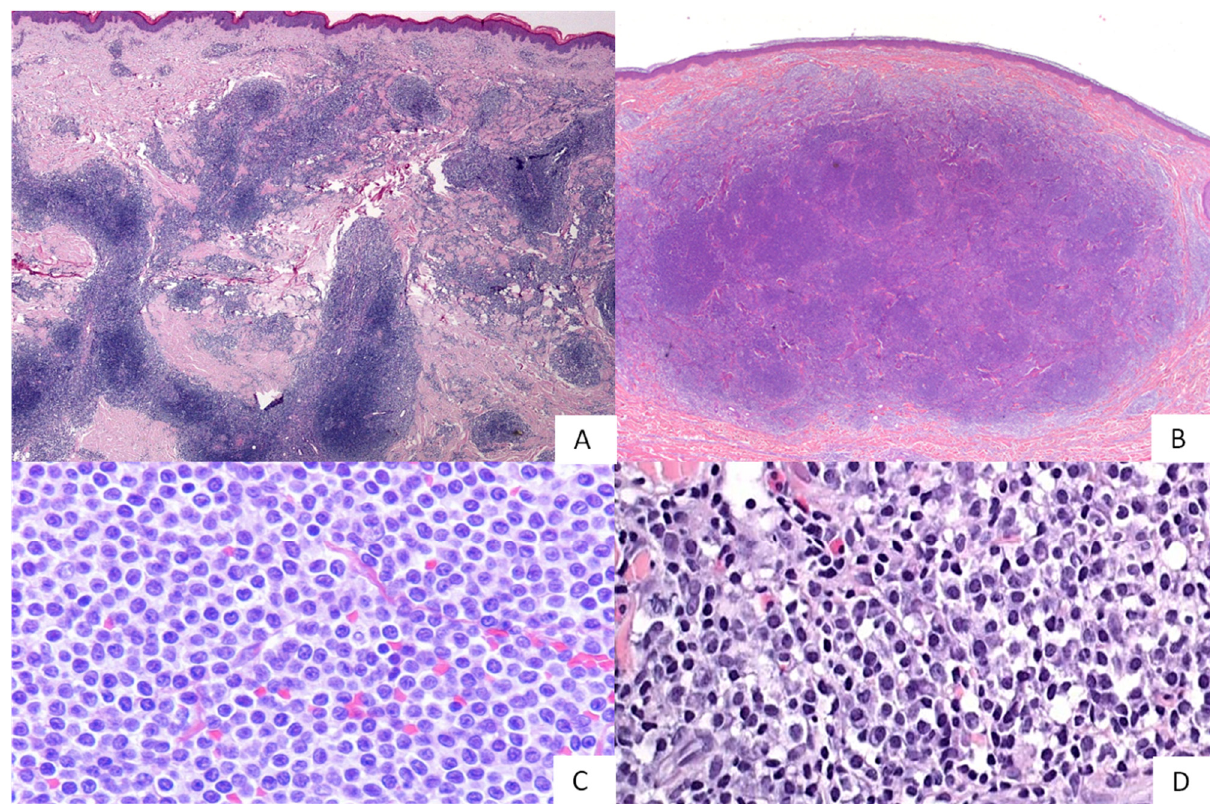
Figure 1. PCMZL. At histological evaluation, this lymphoma shows a nodular (( A ), HE 2×) or a diffuse growth pattern (( B ), HE 2×) and is composed of small ‐ to medium ‐ sized B cells, sometimes with a monocytoid appearance (( C ), HE 40×) or a plasmacytic differentiation (( D ), HE 40×). No specific immunophenotype profile exists for MZLs in general, including cutaneous ones. Lymphoma cells express B-cell antigens (CD19, CD20, CD22 and CD79a), and bcl-2 being negative for CD5, CD10, bcl-6 and Cyclin D1. CD23 expression is variable. Plasma